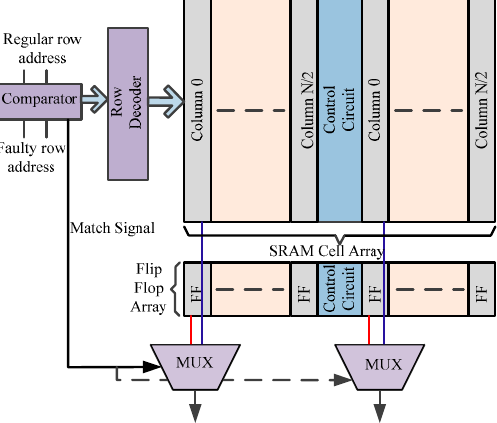
Figure 17. Architecture of row redundancy scheme using flip-flops [55].